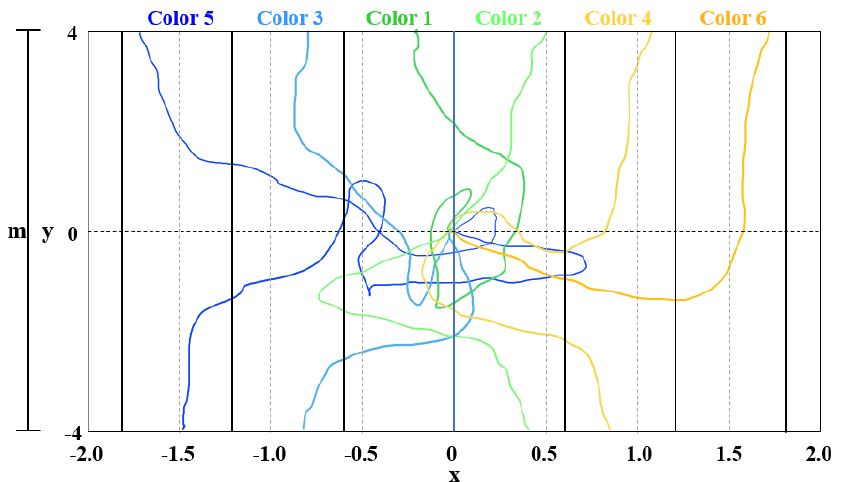
Figure 6. Projections of the switching surfaces perpendicular to the plane (x,y) (black lines). Each colored line depicts the trajectory of a particle that moves along the two-dimensional plane (x,y) due to small changes in the initial conditions. The switching surfaces delimit each potential region that contains a settling point and when the particle crosses it, it represents a potential change in the